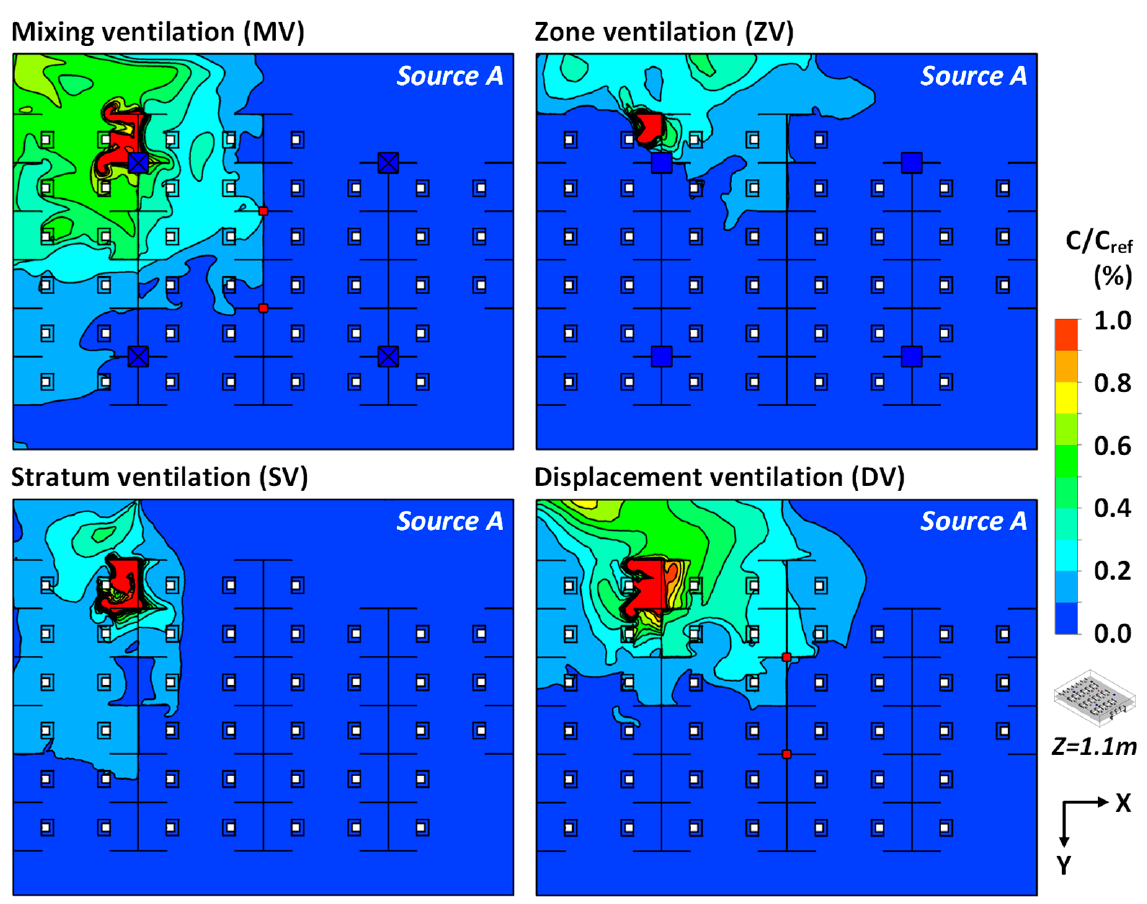
Figure 6. Distribution of relative pollutant concentration (C/C ref ) at the plane of Z = 1.1 m under different ventilation modes of MV, ZV, SV and DV and infected source of A (with a height of physical barrier of 0.6 m).